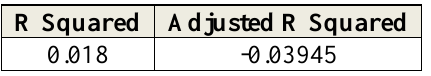
Table 6. The Results of R and R 2